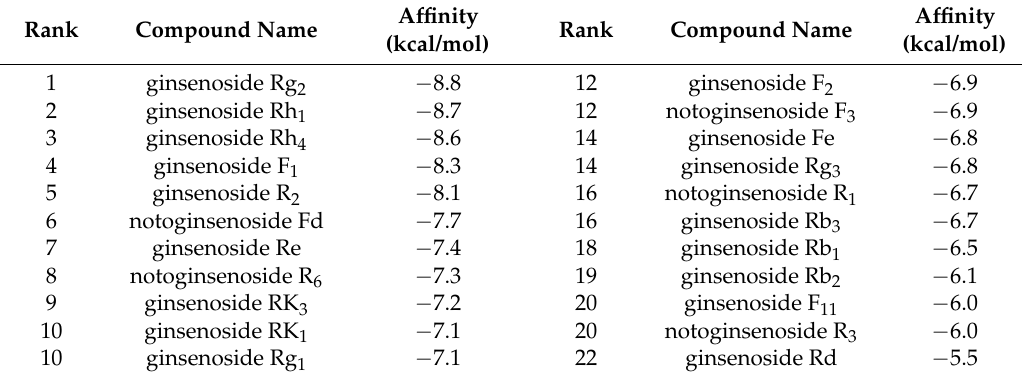
Table 2. Docking scores between the compounds of PNS and hCE2.